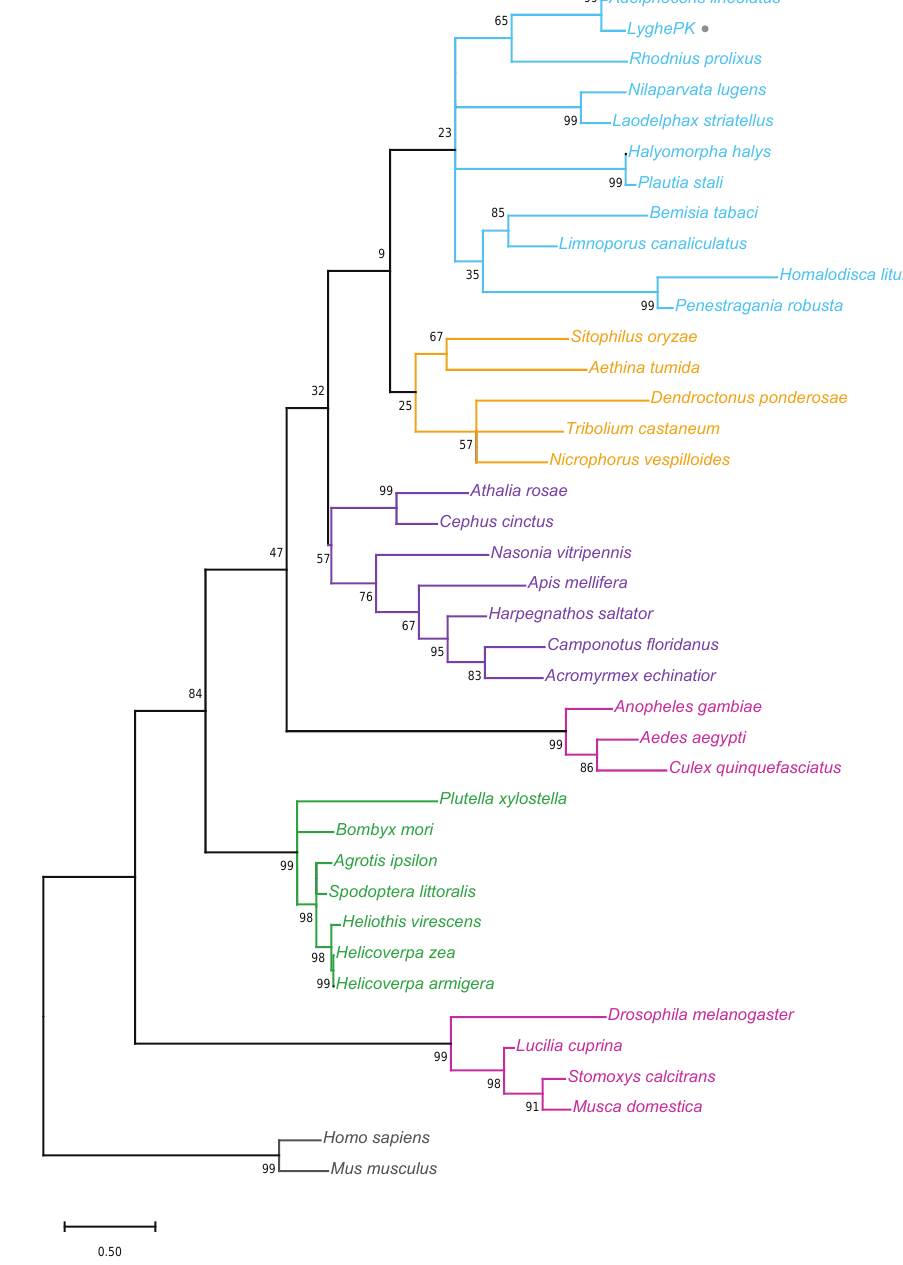
Figure 2. Phylogenetic relationship of the putative Lygus hesperus pyrokinin prepropeptide with sequences from multiple species across five insect orders. The highest log likelihood ( − 4698.53) tree is shown with the percentage of trees that clustered together over 1000 iterations indicated at the branch nodes. The tree is drawn to scale, with branch lengths measured in the number of substitutions per site. LyghePK is marked by a grey circle. Order specific clades have been colored as: Coleoptera — orange; Diptera — magenta; Hemiptera — blue; Hymenoptera — purple; and Lepidoptera — green. The tree was rooted to the human and mouse neuromedin U (the vertebrate PK homolog) sequences (gray). Accession numbers for the proteins used are listed in Table S1.